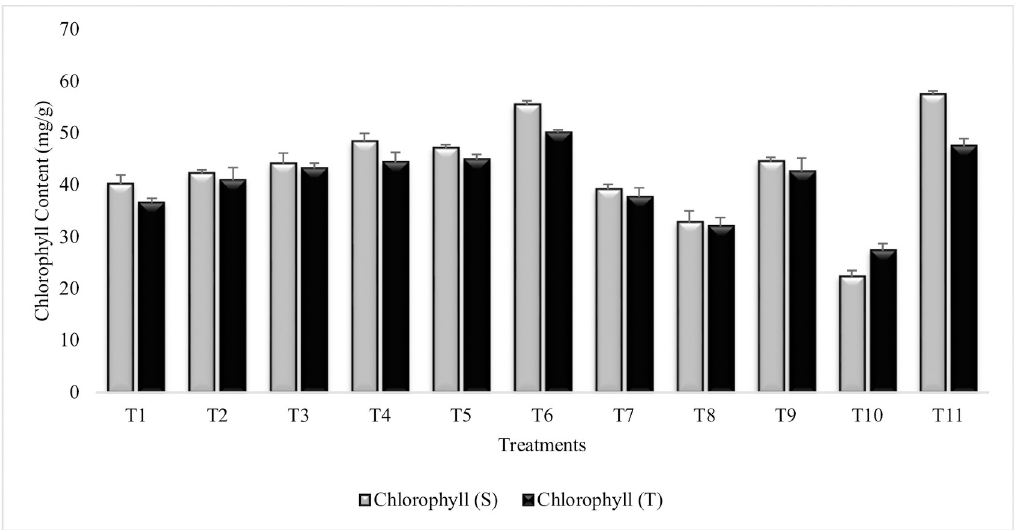
Fig 1. Chlorophyll content of chickpea grown in sandy soil. Data are means of four replicates along with standard error bars (S-Sensitive Variety; T-Tolerant Variety). T 1 - Seeds inoculated with P 1 , T 2 - Seeds inoculated with P 1 + Plants Sprayed with SA and Put, T 3 - Seeds inoculated with P 2 and P 3 , T 4 - Seeds inoculated with P 2 and P 3 + Plants Sprayed with SA and Put, T 5 - Seeds inoculated with